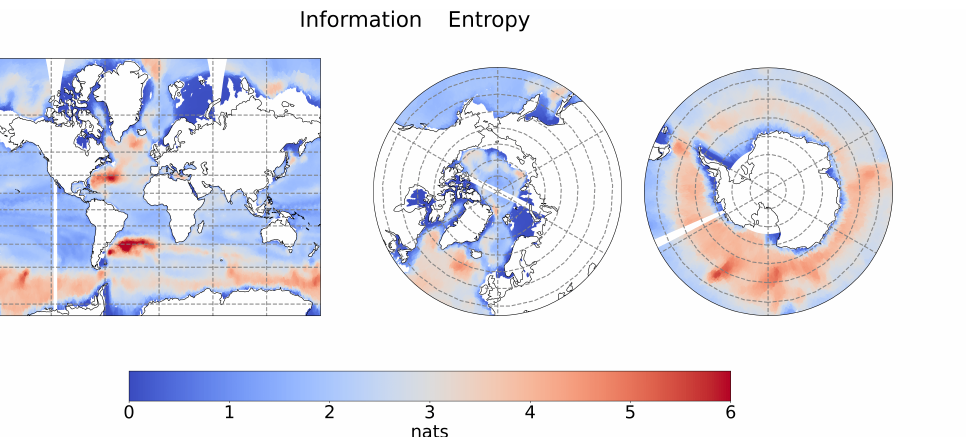
Figure A2. Information entropy field of the temperature at 1250 m depth.